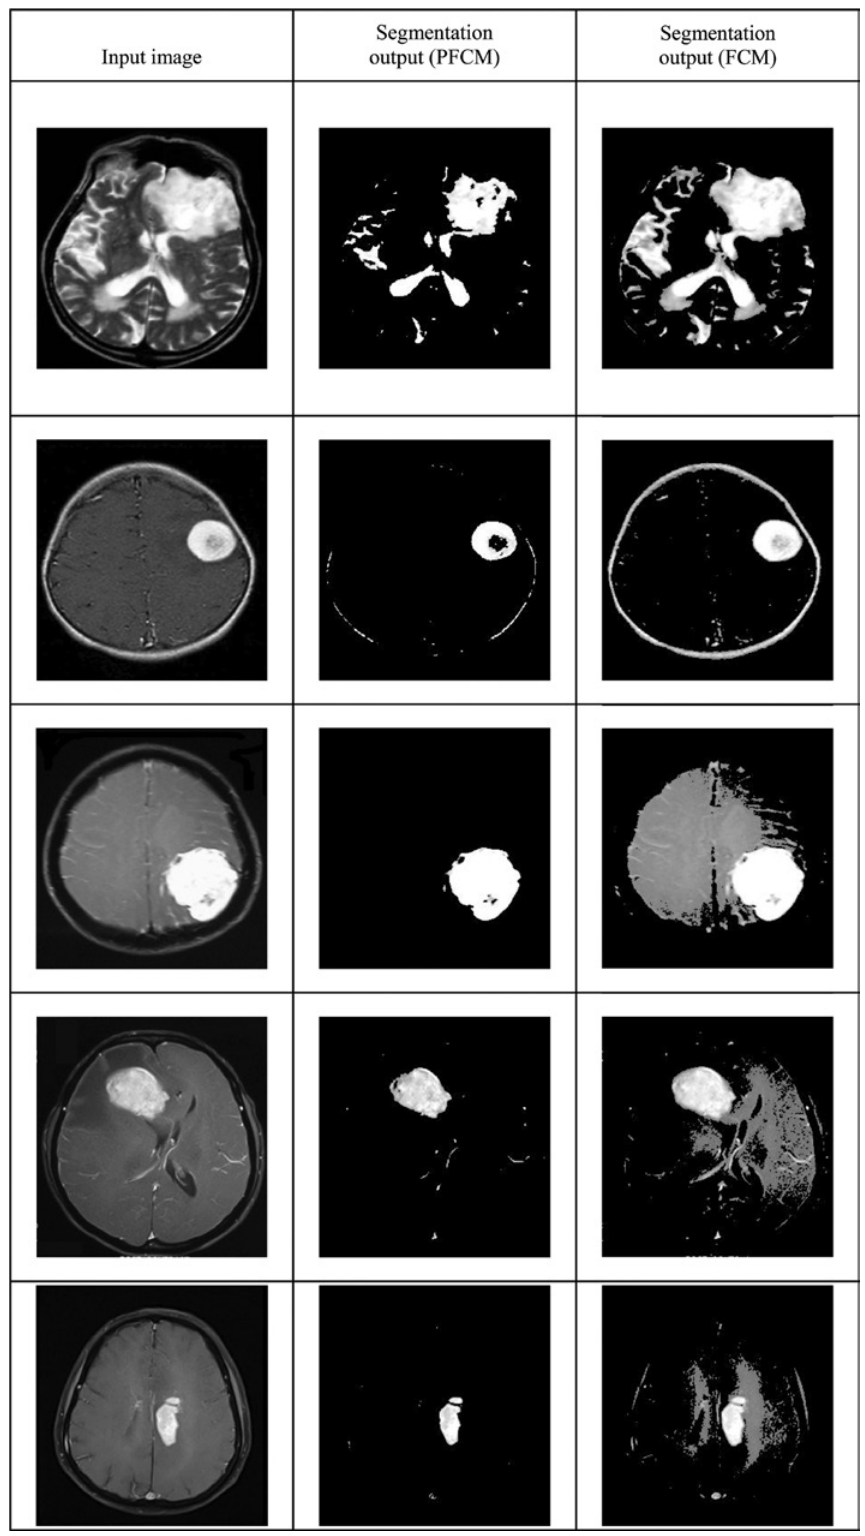
Table 3: Experimental Results of Segmentation